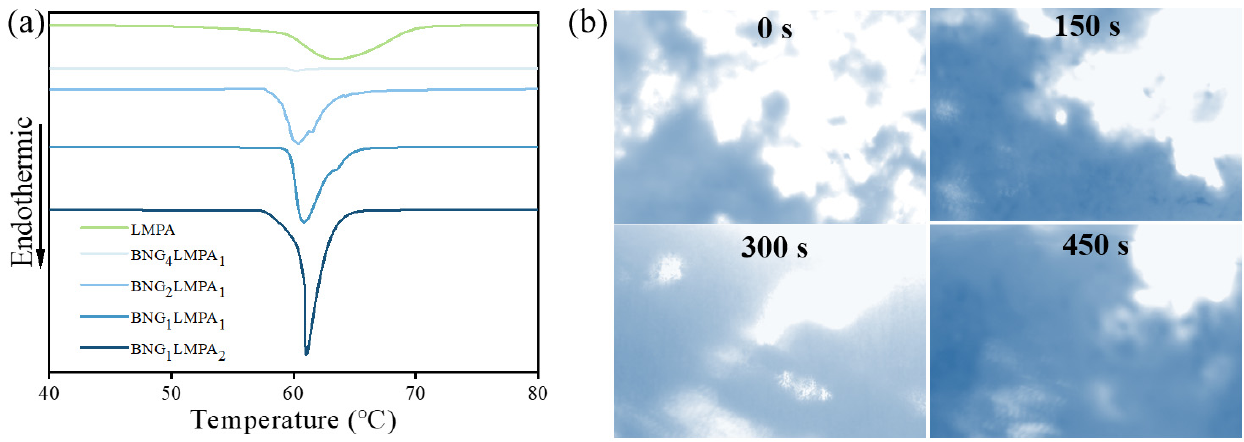
Figure 3. ( a ) DSC curves of BNG-LMPA; ( b ) Morphological changes of BNG 1 LMPA 2 on the hot